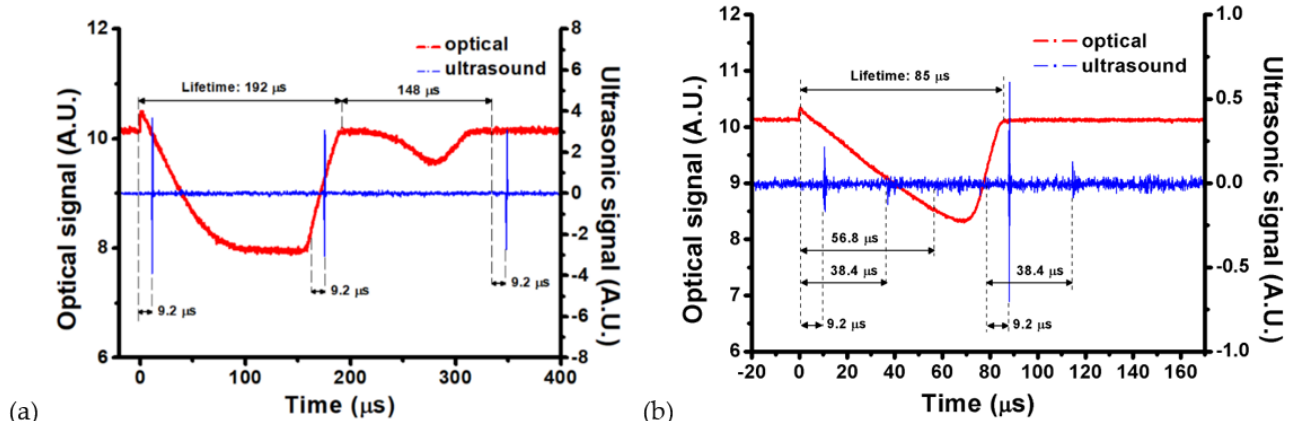
Figure 7. ( a ) Optical (red) and photoacoustic (blue) signals of a typical splitting microbubble in 4 ppm GNR colloid with SPR of 718 nm induced by a 700 nm pulsed laser of 17.66 mJ energy via objective lens (LMH-20X-532, Thorlabs, Newton, NJ, USA). The lifetime of the first cycle of the microbubble is 192 µ s, and that of the second cycle of the split microbubbles is 148 µ s. ( b ) Optical (red) and photoacoustic (blue) signals of a splitting microbubble in 6 ppm GNR colloid with SPR of 966 nm induced by a 980 nm pulsed laser of 13.04 mJ energy via objective lens (LMH-20X-1064, Thorlabs, Newton, NJ, USA).